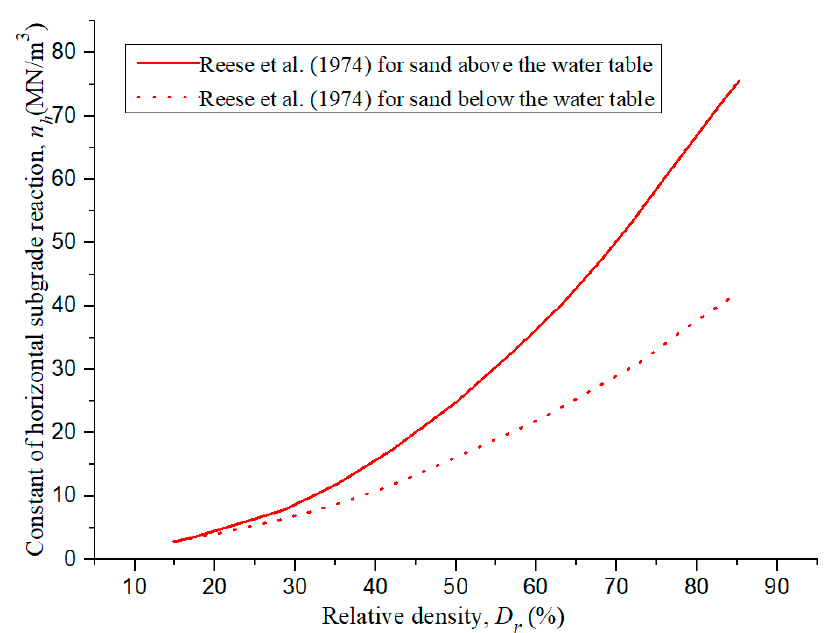
Figure 6. The relation between 𝑛 (cid:3035) and 𝐷 (cid:3045) [13].